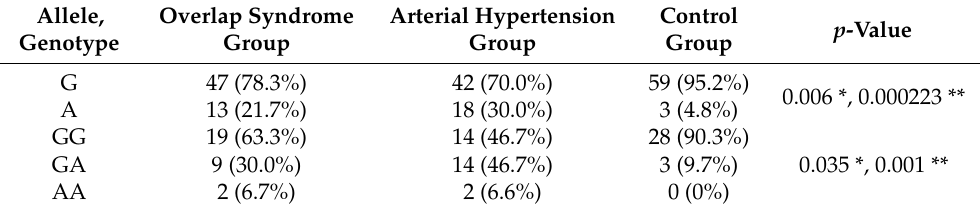
Table 2. Allele frequencies and genotype distribution of rs2297518 of the NOS2 gene. Allele, Overlap Syndrome Genotype